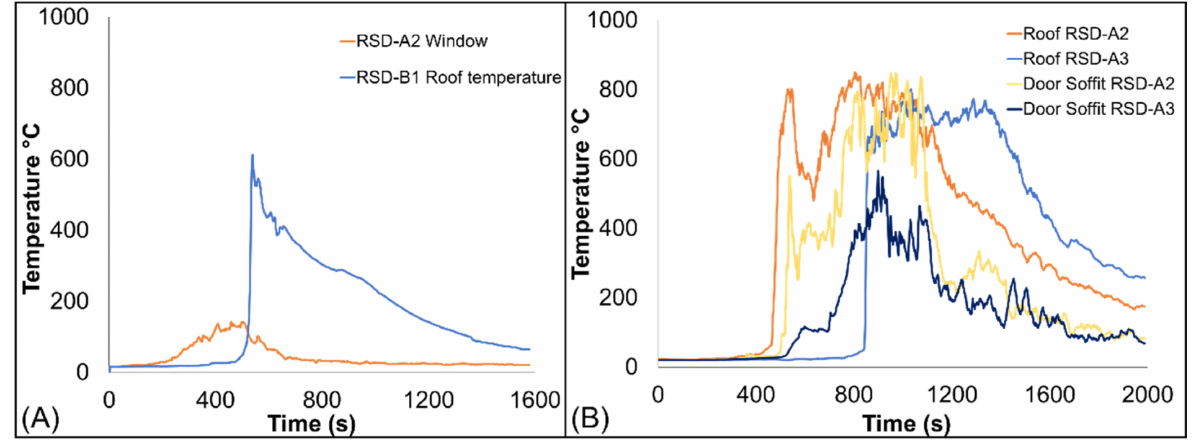
Figure 9. Three RSD experiment: ( A ) test 7: fire spread by RSD-01; ( B ) test 10: roof temperatures and door soffit temperatures.